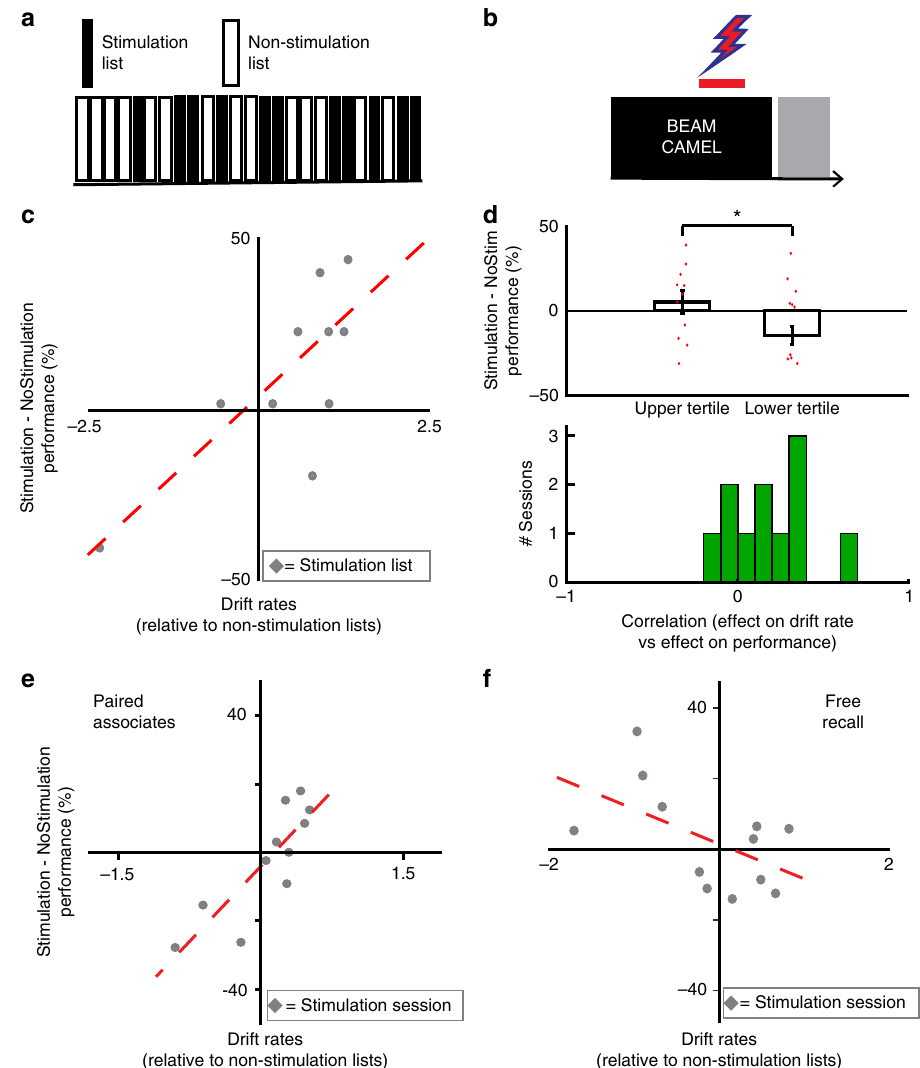
Fig. 4 Electrical stimulation modulates rate of neural drift and memory performance. a For each session, 11 randomly chosen stimulation lists are interleaved with 11 non-stimulation lists. b During stimulation lists, electrical stimulation is applied during the encoding period. c Changes in the rate of neural drift due to stimulation and changes in memory performance due to stimulation, in a single exemplar participant in the paired associates task. Each data point represents a unique stimulation list. d Top, Change in memory performance in each experimental session between the highest and lowest tercile of lists, ranked by the changes in drift rate due to stimulation. Error bars represent SEM across 11 unique stimulation sites at which stimulation was applied. Bottom, Changes in the rate of neural drift due to stimulation and changes in memory performance in the paired associates task across experimental sessions. Each data point represents strength of correlation between stimulation-induced changes in drift rate and stimulation-induced changes in performance during an experimental session in which stimulation was applied at a unique pair of electrodes. e Average changes in the rate of neural drift due to stimulation and average changes in memory performance due to stimulation, in the paired associates task. Each data point represents a unique stimulation site at which stimulation was applied. f Average changes in the rate of neural drift due to stimulation and average changes in memory performance due to stimulation, in the free recall task. Each data point represents a unique stimulation site at which stimulation was